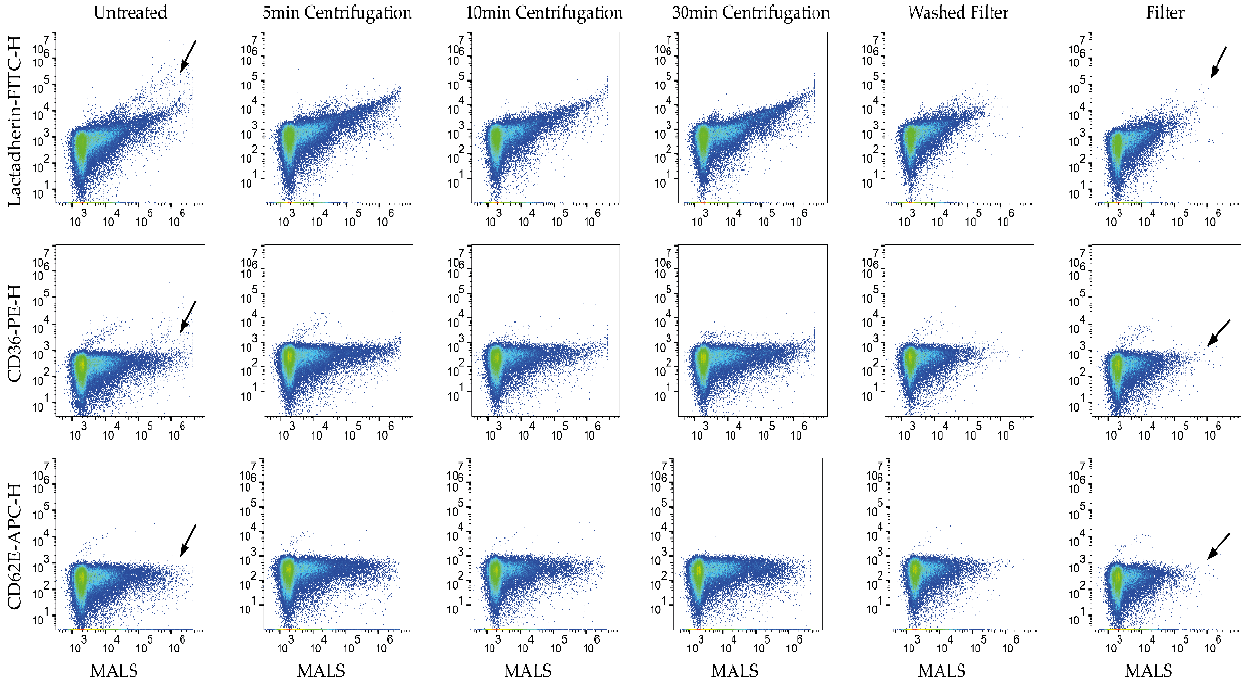
Figure 2. Representative scatterplots of phosphate buffered saline (PBS) labeled with P1 specific label. Medium angle light scatter (MALS) versus fluorescence. Colum’s represent untreated, centrifugated, and filtered labels.